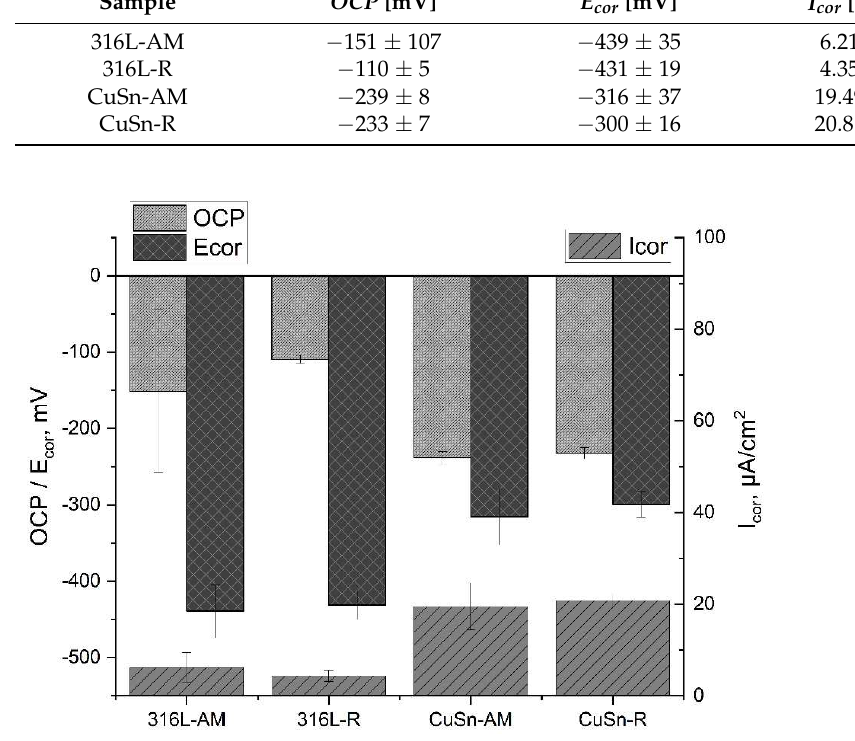
Figure 11. Comparison of the LSV results of additively produced samples with the rolled